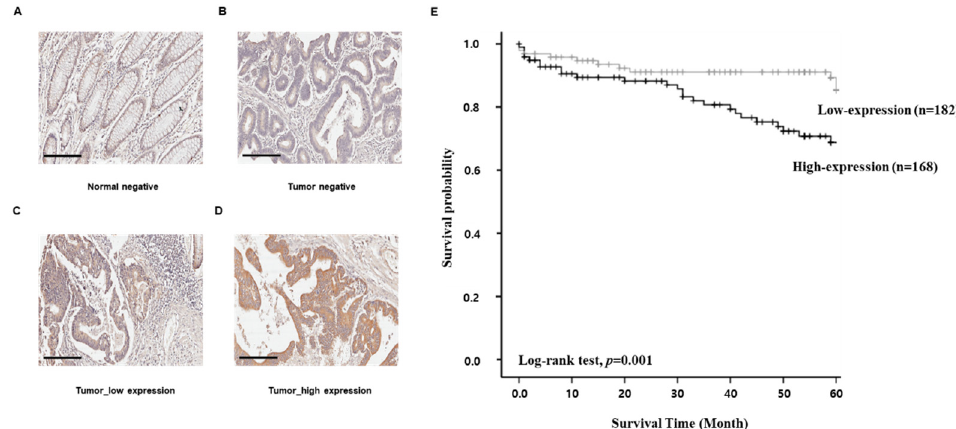
Figure 5. The result of IHC for SMOX expression in CRC ( A – D ). In total, 350 specimens were used, which were scored by multiplying the staining frequency and staining intensity. Low/High expression of SMOX was discovered in 182/168 CRC tissues. The Kaplan–Meier survival analysis was performed for all the sampled CRC patients, based on numerous variables and their expression of SMOX. SMOX proteins and nuclei were visualized by brown and violet, respectively. ( A ) Normal tissue without expression of SMOX (Original magnification X 200). ( B ) Cancer tissue without expression of SMOX (Original magnification X 200). ( C ) Cancer tissue with low expression of SMOX (Original magnification X 200). ( D ) Cancer tissue with high expression of SMOX (Original magnification X 200). ( E ) SMOX expression and overall survival of colon cancer patients were related. Following the expression of SMOX, patients were divided into two groups and the survival rate was determined using a Kaplan–Meier analysis ( p = 0.001). Table 2. Cox regression analysis of the clinicopathological factors in